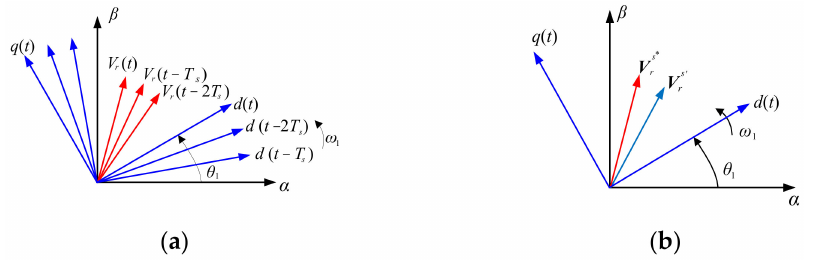
Figure 14. Vector diagrams. ( a ) Synchronous coordinate and voltage vector rotation. ( b ) Action effect diagram of voltage